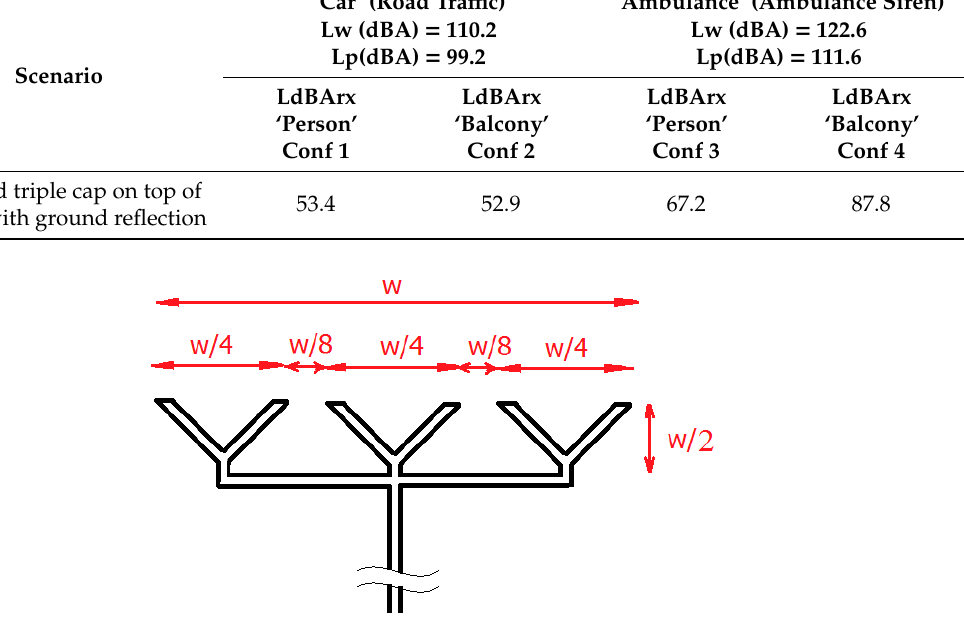
Figure 31. Triple Figure 31. Triple Y-cap. Table 3. Global SPL (dBA) at the receiver positions for Y-shaped triple caps.